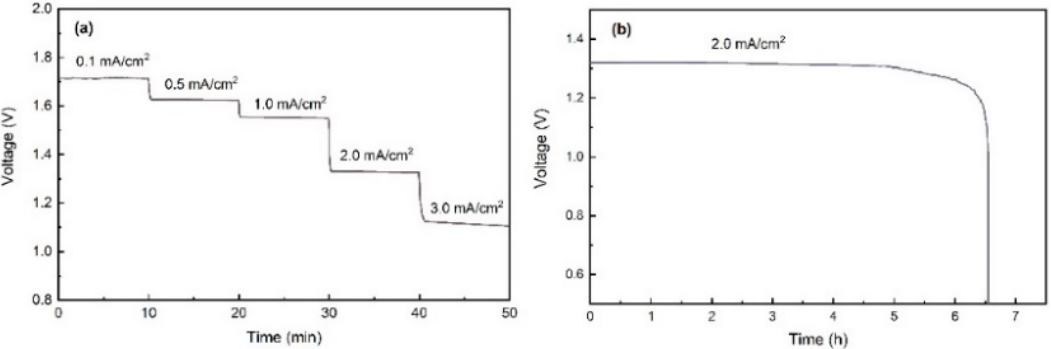
Figure 4. ( a ) Rate discharge curves of Al-air battery at flat state. ( b ) Galvanostatic discharge curve of Al-air battery at 2 mA/cm 2 with flat state.